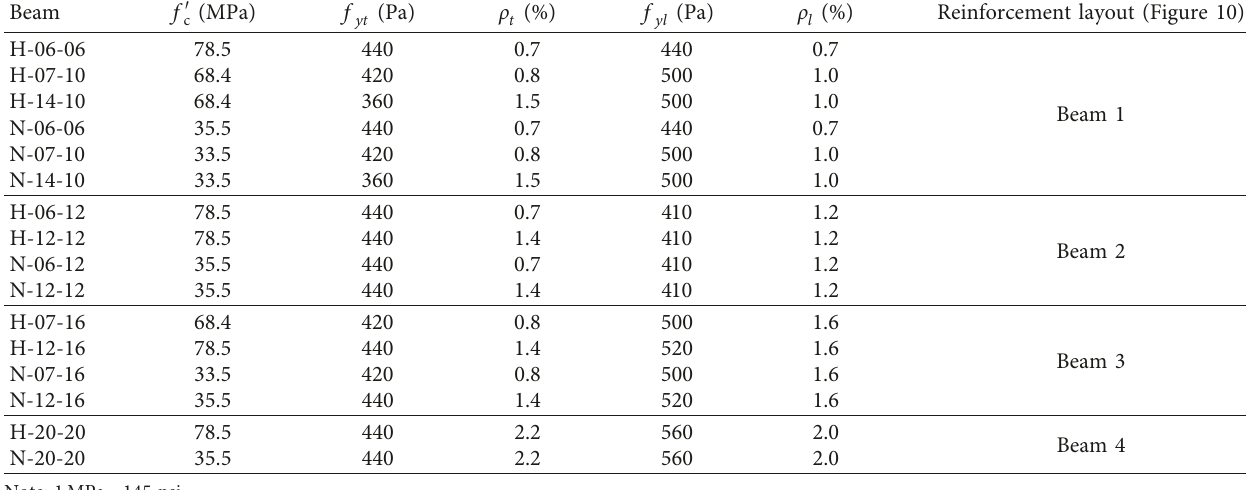
Table 1: Material properties of specimens.